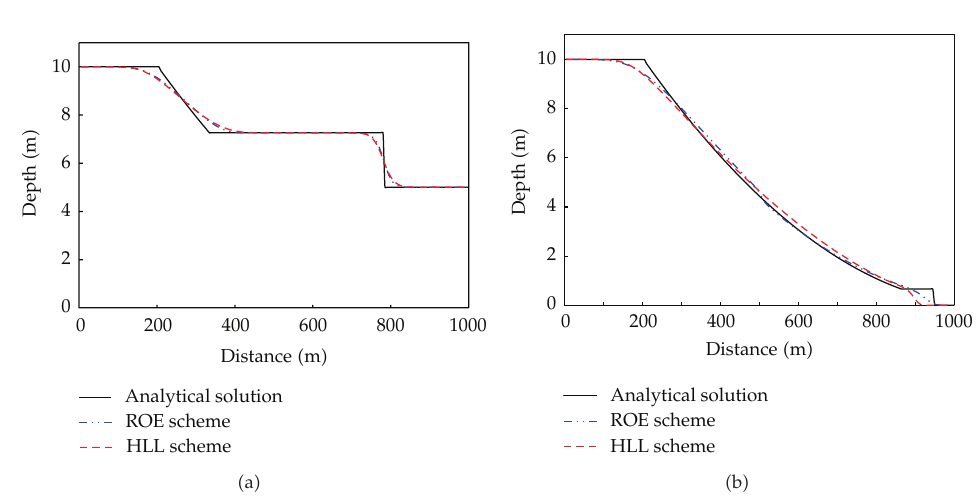
Figure 1: Idealized dam-break problem: (cid:5) a (cid:6) initial depth ratio H r /H t (cid:9) 2; (cid:5) b (cid:6) initial depth ratio H r /H t (cid:9)